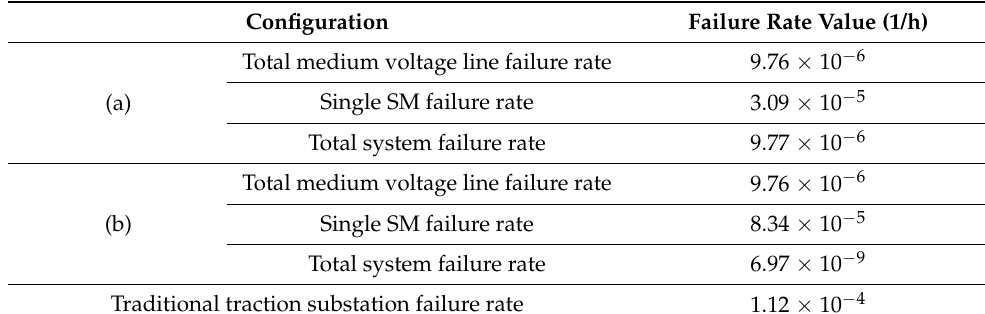
Table 8. The results of failure rates